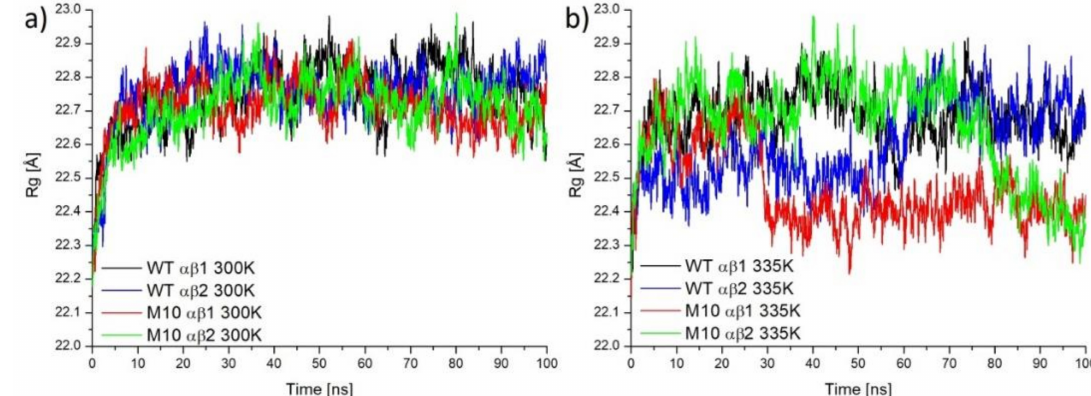
Figure 6. The radius of gyration for WT Pt NHase (black and blue lines) and M10 variant (red and green lines), calculated based on simulations in 300 K ( a ) and 335 K ( b ).